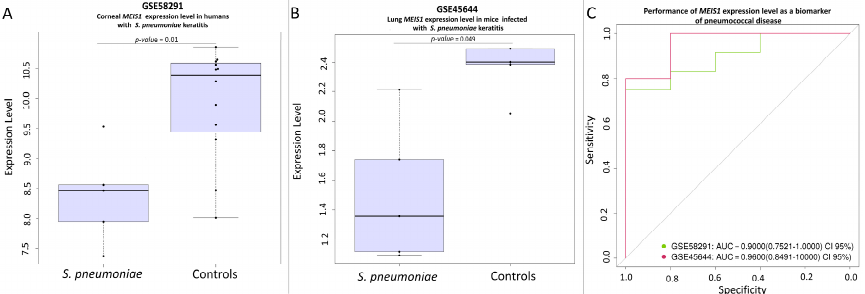
Figure 4. ( A ) Differential expression level of the MEIS1 gene between corneal tissue from corpses and corneal tissue from S. pneumoniae keratitis patients in the study GSE58291. ( B ) Differential lung expression level of MEIS1 gene between healthy mice and S. pneumoniae infected mice in the study GSE45644. ( C ) Receiver operating curve (ROC evaluating the potential of the gene MEIS1 as a biomarker in the studies GSE58291, and GSE45644. AUC: area under the curve. Genes 2018 , 9 , x FOR PEER REVIEW